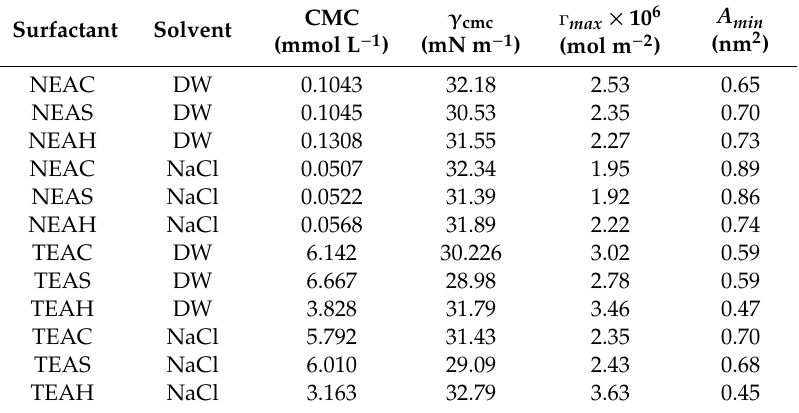
Figure 12. The effect of the tail on the of surface tension in DW at 30 °C. Table 6. Surface properties of surfactants in DW and in 1M NaCl solution at 30 °C.